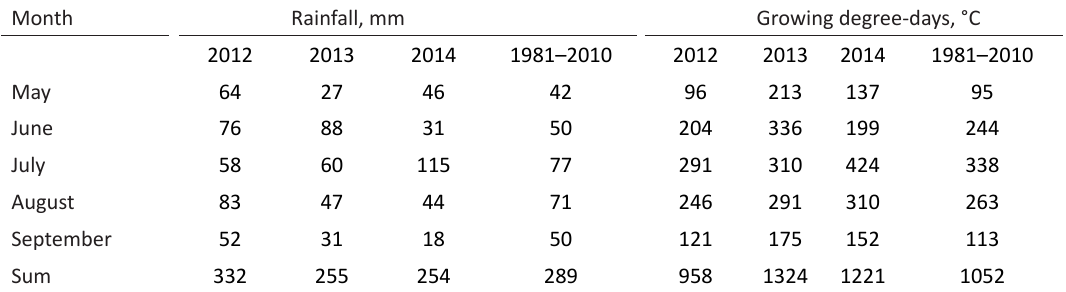
Table 5. Weather conditions at Ruukki during 2012–2014 and long-term averages 1981–2010 (Finnish Meteorological Institute)